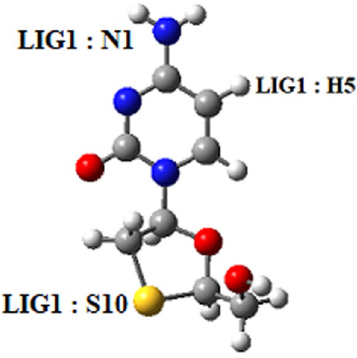
Figure 6. The position of H5, S10, and N1 atoms in 3TC molecule.